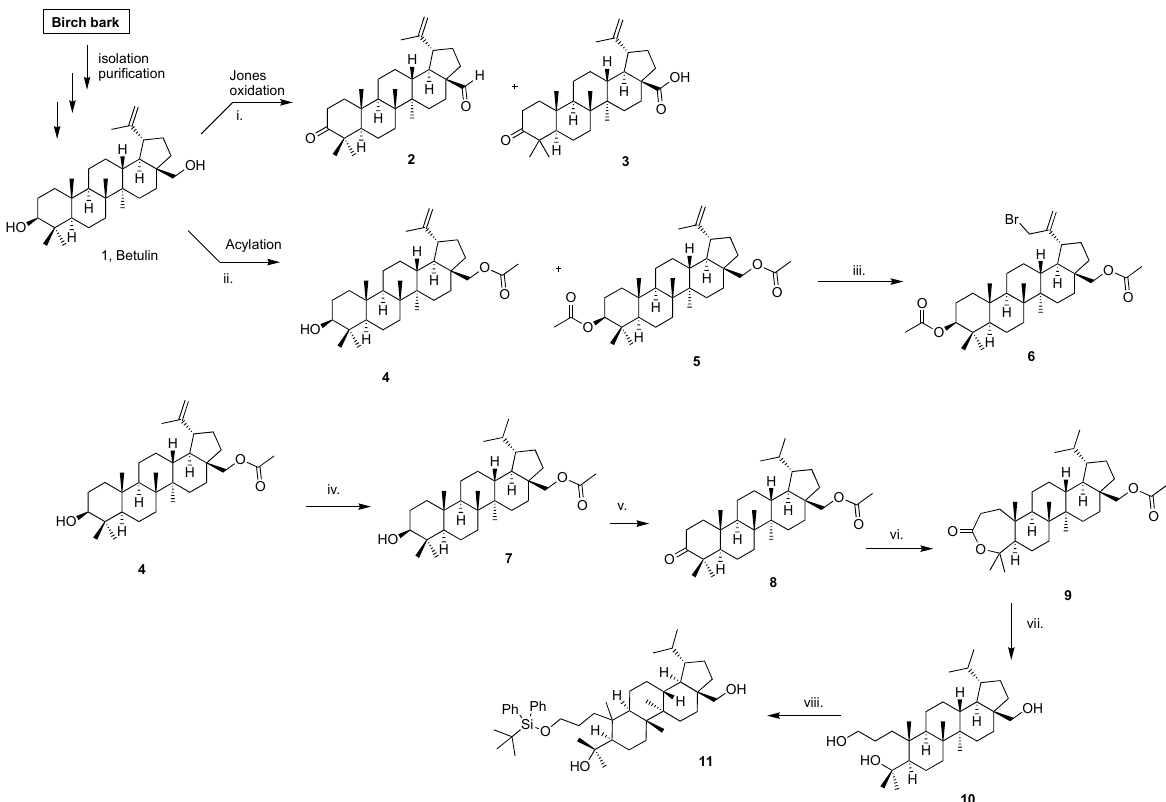
Figure 1. Synthesis of betulin derivatives. Reagent and conditions: i. Jones oxidation, CrO 3 , aq. H 2 SO 4 , acetone, 0 °C, (N 2 atm); ii. DMAP, pyridine, Ac 2 O, 0 °C; iii.NBS, CCl 4 ; iv. MeOH/THF, 10% Pd/C, H 2 (40 psi); v. DCM, PCC, 0 °C; vi. chloroform, 70%-mCPBA, 35 °C; vii. THF, LiAlH 4 , − 40 °C; viii. imidazole, THF, TBDPSCl, − 70 °C.